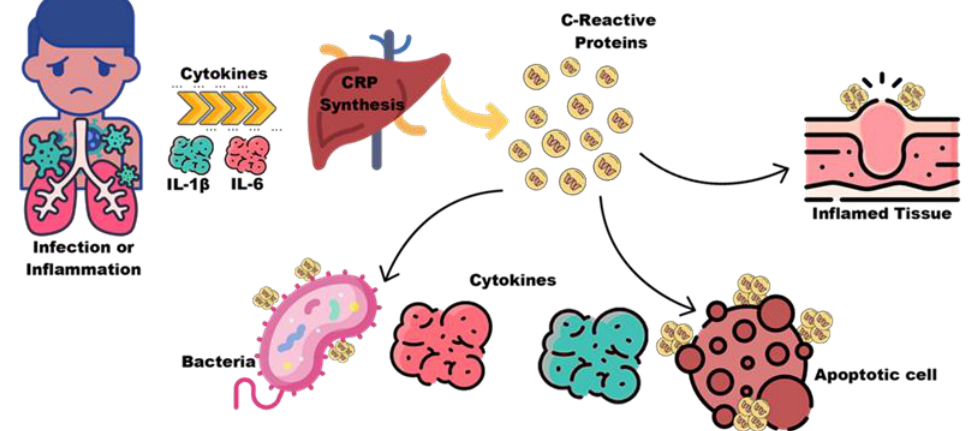
Figure 6. Schematic of C-reactive protein and cytokines the functional pathways of CRP.